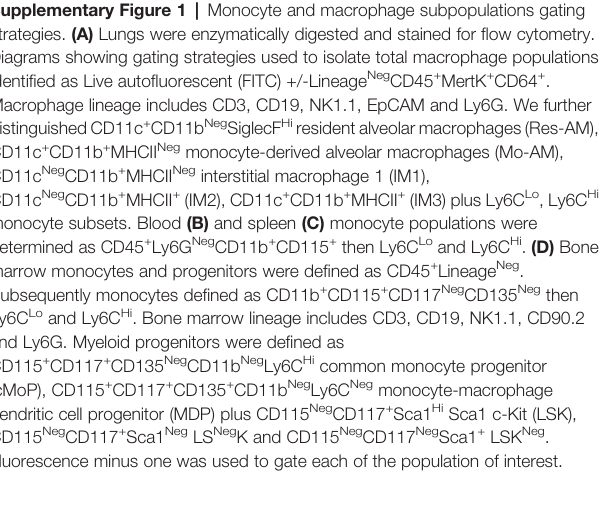
Supplementary Figure 2 | Macrophage size and granularity following cigarette smoke exposure. (A) Median fl uorescent intensity of siglecF expression for all macrophage subpopulations at 12 weeks CS exposure. Data show total numbers of (B) lung (2-, 12-, 24-weeks) and BAL (8-weeks) cells following CS exposure. (C) Res-AM, Mo-AM, IM1, IM2, and IM3 population size measured by forward